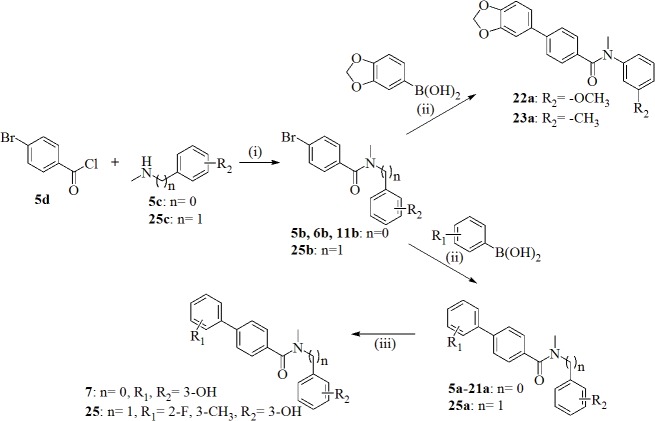
Synthesis of 1,4-Phenyl Derivatives 5a-23a, 25a, 7, 25.Reagents and conditions: (i) Et3N, CH2Cl2, room temperature, overnight; (ii) DME/EtOH/H2O (1:1:1), Cs2CO3, Pd(PPh3)4, microwave irradiation (150°C, 150W, 20 min); (iii) BF3·SMe2, CH2Cl2, room temperature, overnight.